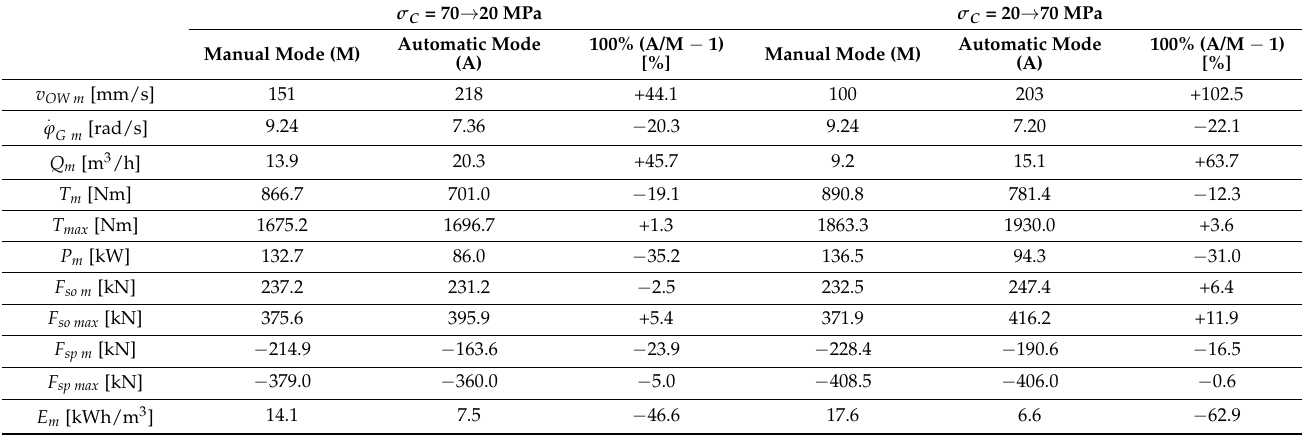
Legend: m —average value, max —peak value of a given